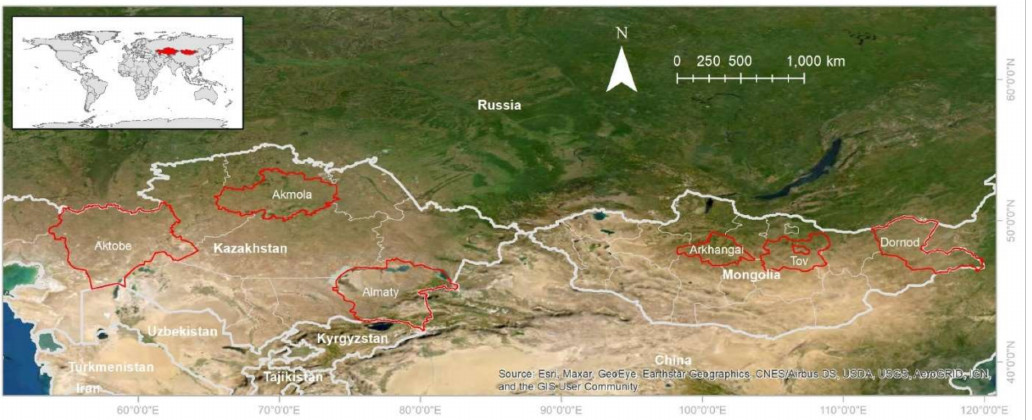
Figure 1. Positions of six provinces in two largest landlocked countries, including Aktobe, Akmola, and Almaty province in Kazakhstan, and Arkhangai, Tov, and Dornod in Mongolia which are highlighted by red line. The six provinces are selected based on their position along the climate, landscape composition, and socioeconomic